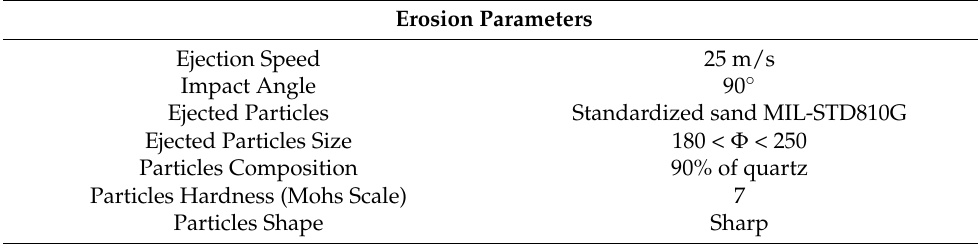
Table 1. Erosion